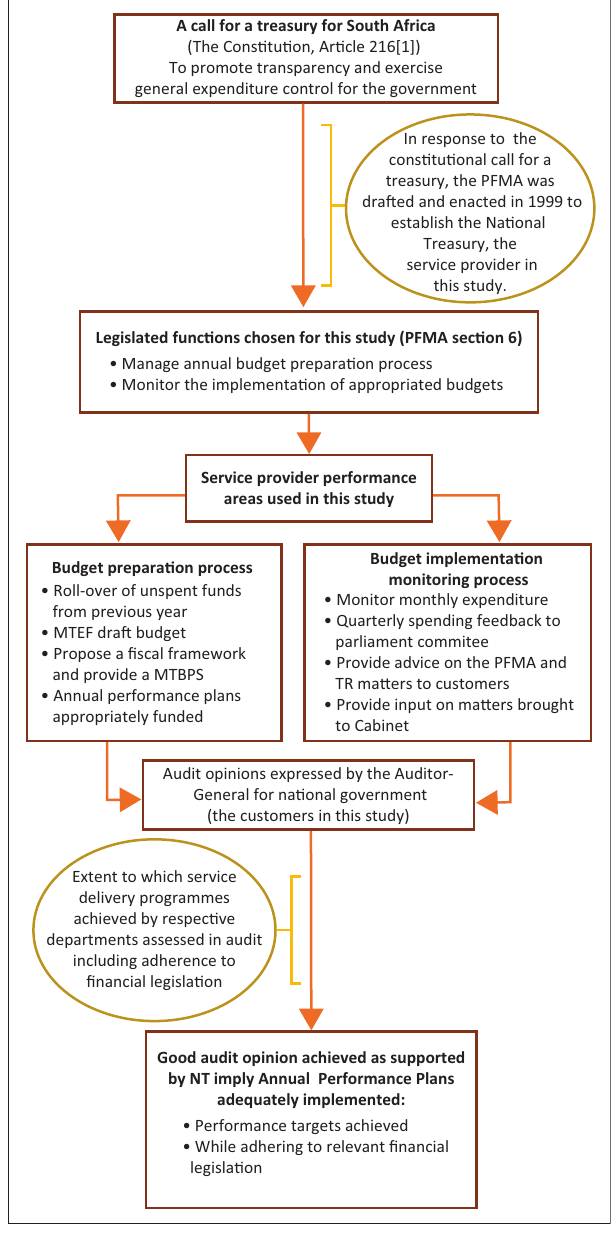
FIGURE 1: Suggested link between National Treasury functions used and service delivery